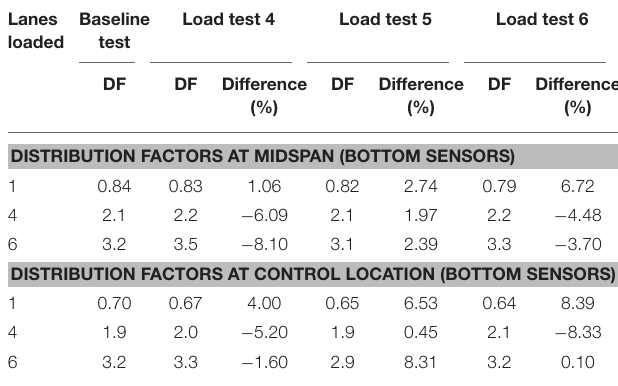
TABLE 6 | Baseline distribution factors at midspan and controlling location compared to distribution factors from load tests 4, 5, and 6.